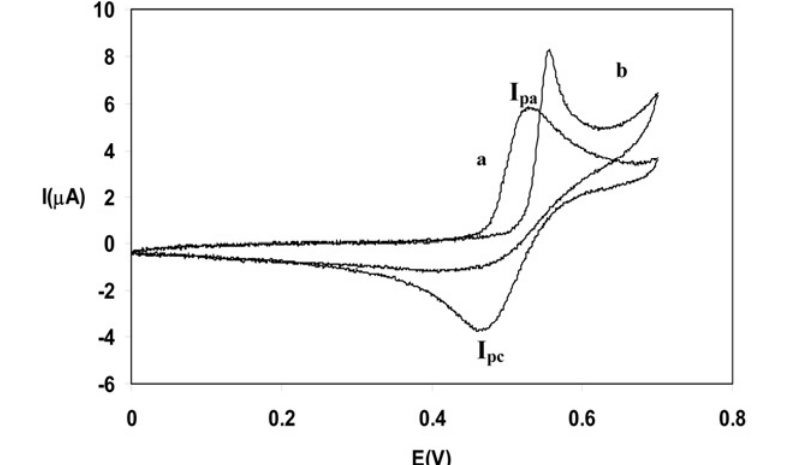
Figure 1. Cyclic voltammograms of 1×10 -3 M sodium iodide: (a) in the absence and (b) in the presence of 1×10 -3 M phenol, at GC electrode in aqueous solution containing 0.2 M acetate buffer (pH 4.8), scan rate 20 mVs -1